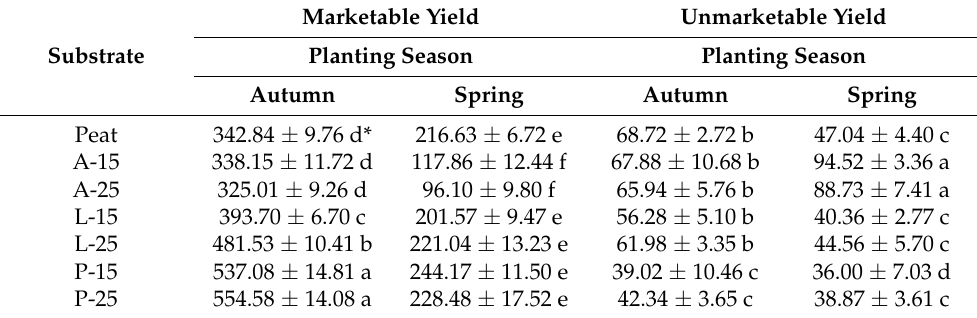
Table 11. Cumulative marketable and unmarketable yields (g · plant − 1 ) as influenced by substrates and planting season.